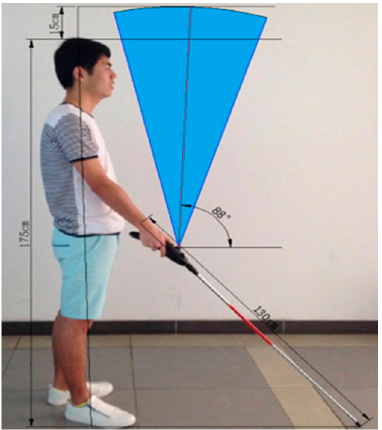
Figure 32. The proposed crutch with displayed detection ranges [54].